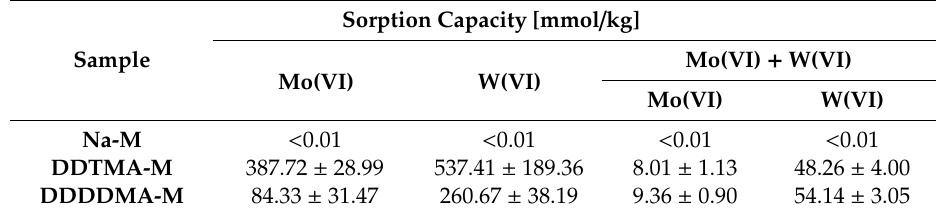
Table 1. Sorption capacities of Na-M, DDTMA-M, and DDDDMA-M regarding Mo(VI) and W(VI) ions